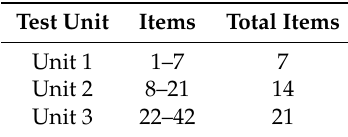
Table 1. Item distribution per